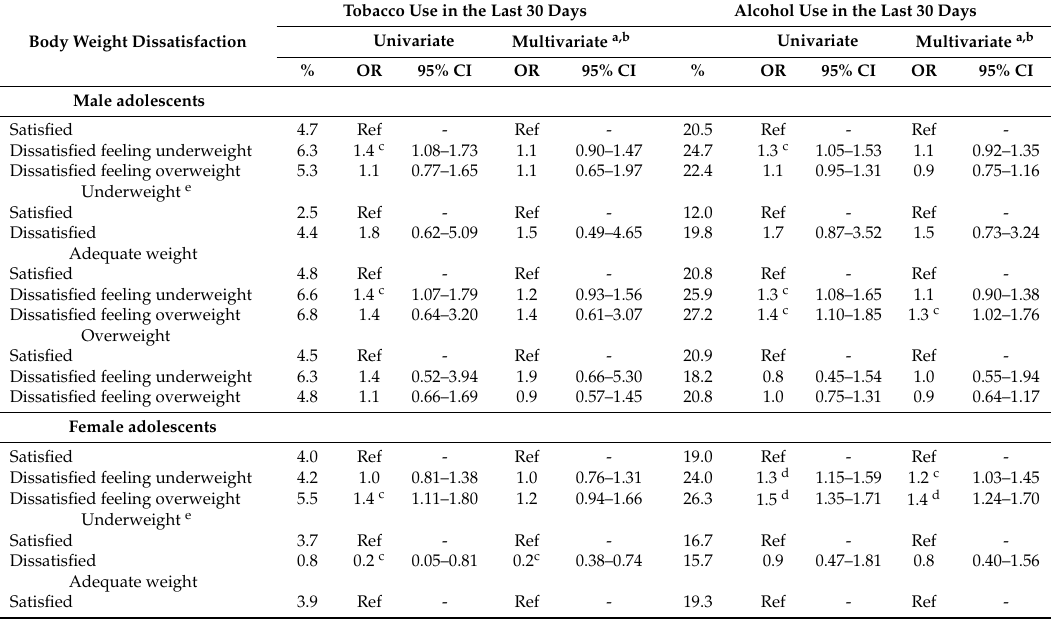
Table 3. Association between two forms of body weight dissatisfaction and cardiovascular health-risk behaviors tobacco use and alcohol use in the last 30 days, by